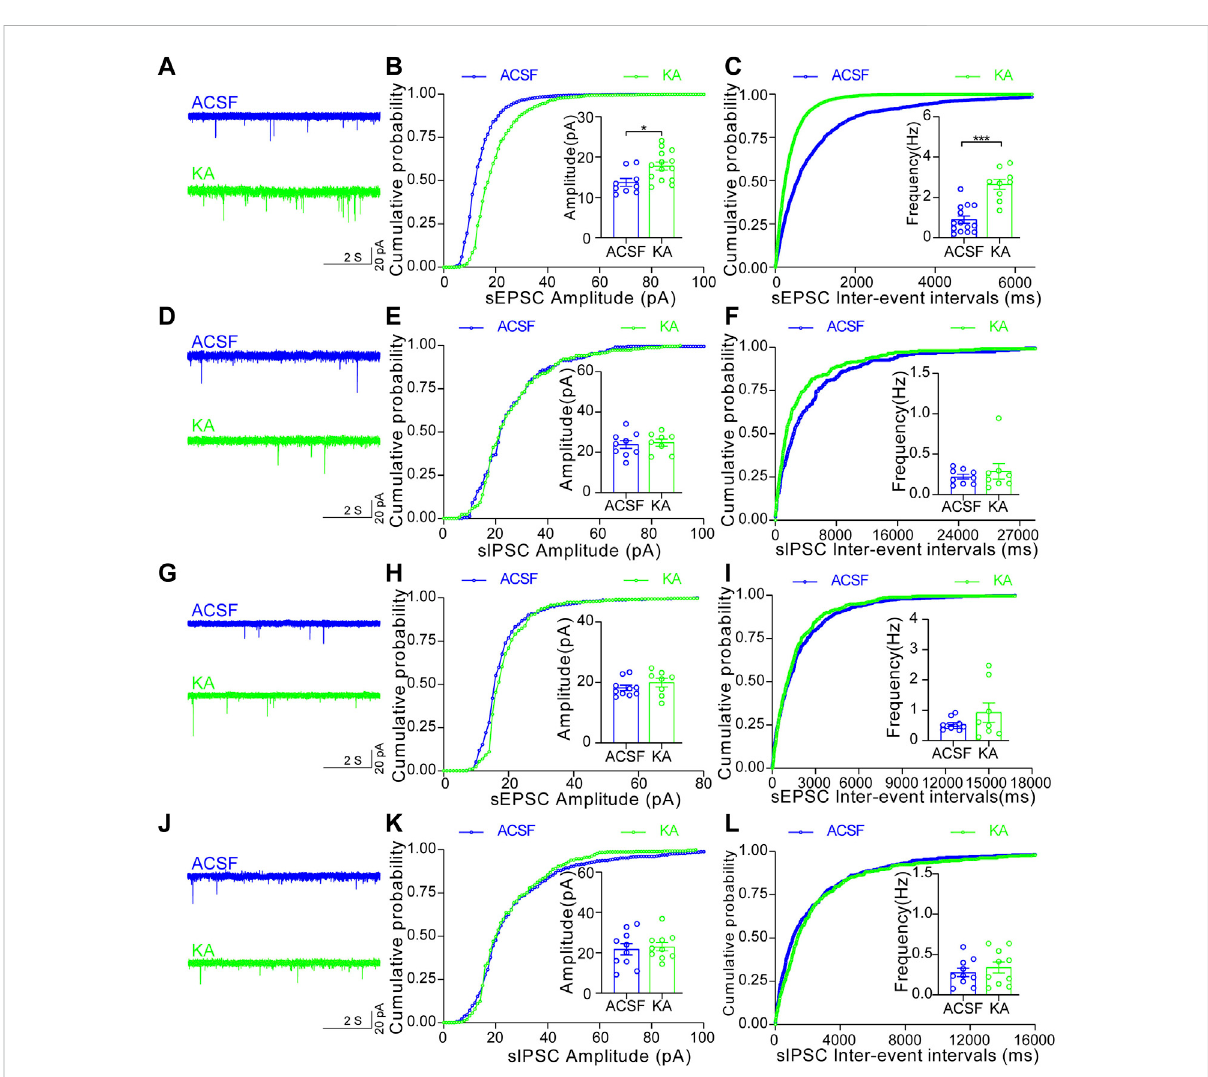
FIGURE 4 Increased synaptic transmission of D1R-MSN, but not D2R-MSN, in the NAc shell after TLE seizures. (A) Representative sEPSC of D1R-MSN of the mice treated with ACSF or KA. (B) Cumulative probability of the amplitudes and the averaged amplitude of sEPSCs of D1R-MSN of the mice treated with ACSF ( n = 9 cells) or KA ( n = 14 cells). * p < 0.05, Student ’ s unpaired t-test (the same test was used below in this fi gure). (C) Cumulative probabilityoftheinter-eventintervalsofsEPSCsandtheaveragedfrequencyofsEPSCsofD1R-MSNofthemicetreatedwithACSF( n =14cells) orKA( n =9cells).*** p < 0.001. (D) RepresentativerecordingsofsIPSCofD1R-MSNofthemicetreatedwithACSForKA. (E) Cumulativeprobabilityof the amplitudes and the averaged amplitude of sIPSCs of D1R-MSN of the mice treated with ACSF ( n = 9 cells) or KA ( n = 8 cells). (F) Cumulative probability of the inter-event intervals of sIPSCs and the averaged frequency of sIPSCs of D1R-MSN of the mice treated with ACSF ( n = 9 cells) or KA ( n = 8 cells). (G) Representative recordings of sEPSC of D2R-MSN of the mice treated with ACSF or KA. (H) Cumulative probability of the amplitudes and the averaged amplitude of sEPSCs of D2R-MSN of the mice treated with ACSF ( n = 10 cells) or KA ( n = 8 cells). (I) Cumulative probability of the inter-event intervals of sEPSCs and theaveraged frequency of sEPSCs ofD2R-MSN of the mice treated with ACSF ( n = 10 cells)or KA ( n = 8 cells). (J) Representative recordings of sIPSC of D2R-MSN of the mice treated with ACSF or KA. (K) Cumulative probability of the amplitudes and theaveraged amplitudeofsIPSCsofD2R-MSNofthemicetreatedwithACSF( n =10cells)orKA( n =10cells). (L) Cumulativeprobabilityoftheinter-eventintervals of sIPSCs and the averaged frequency of sIPSCs of D2R-MSN of the mice treated with ACSF ( n = 10 cells) or KA ( n = 10